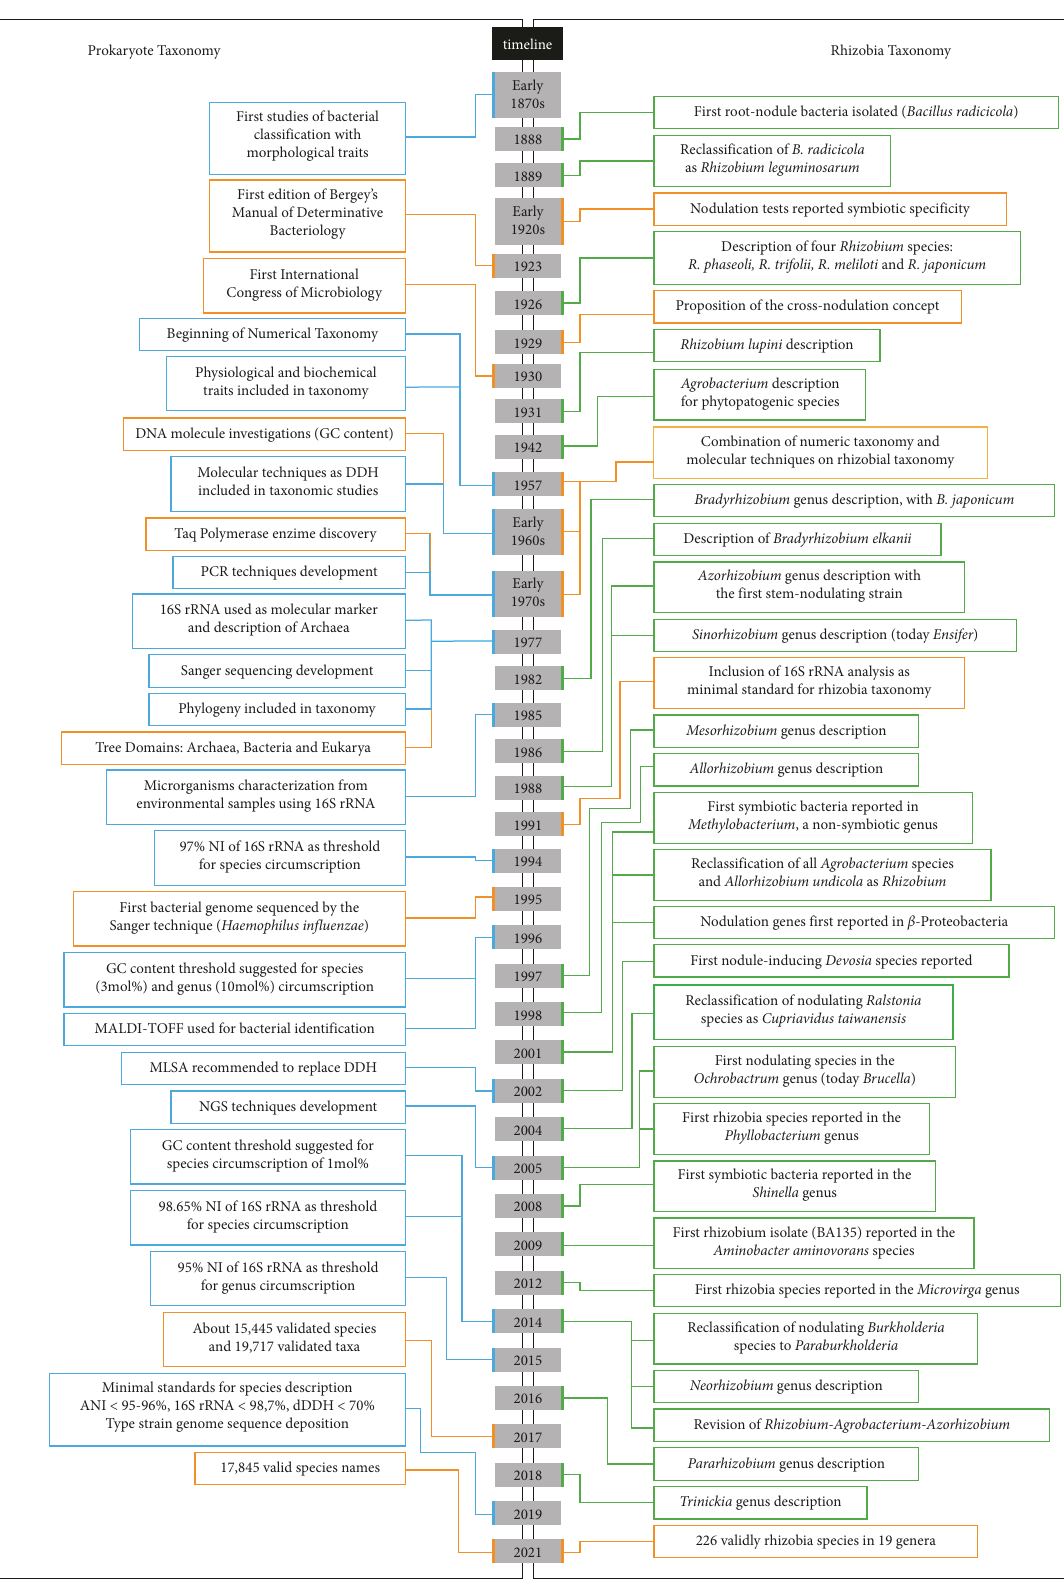
Figure 1: Timeline showing the evolution of methods and achievements in prokaryote and rhizobia